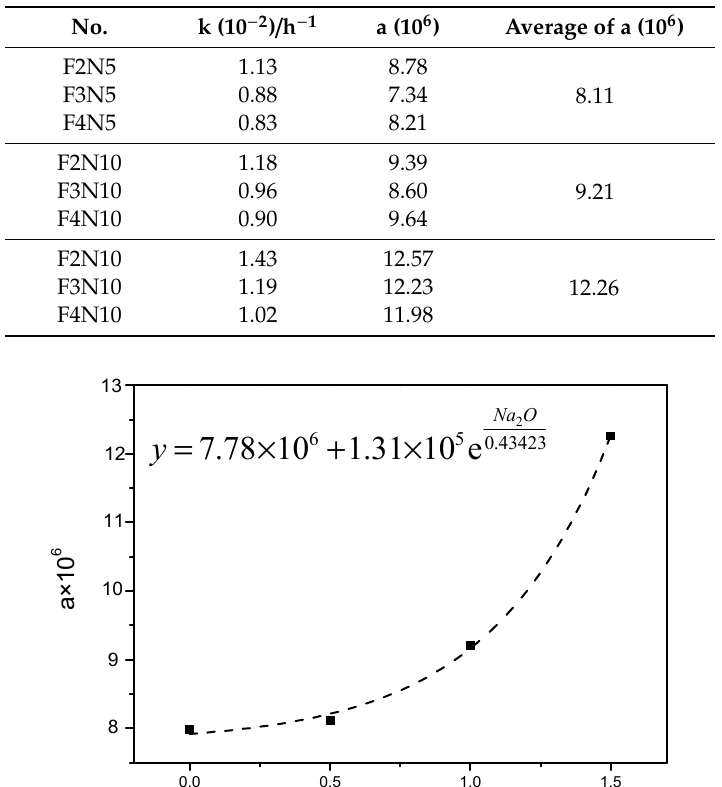
Table 5. Value of a with different Na 2 O addition.